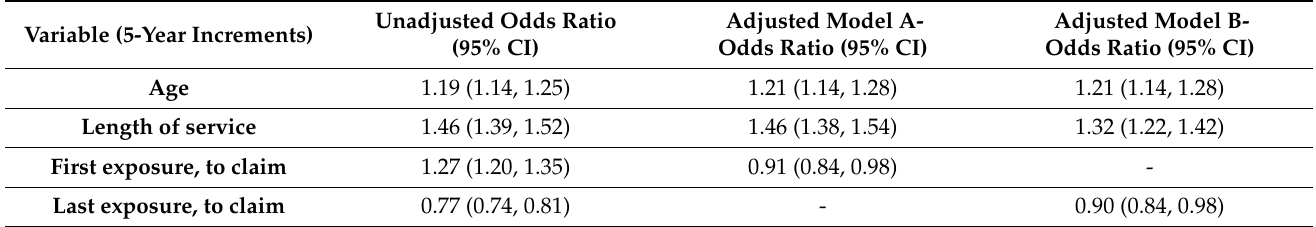
Table 3. Unadjusted and adjusted predictive models of compensable silicosis.